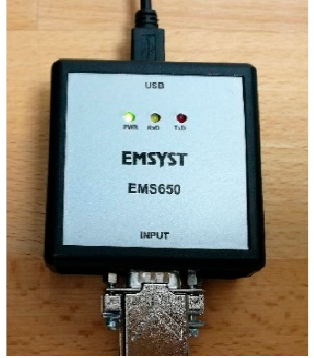
Figure 4. Emsyst EMS650 converter.